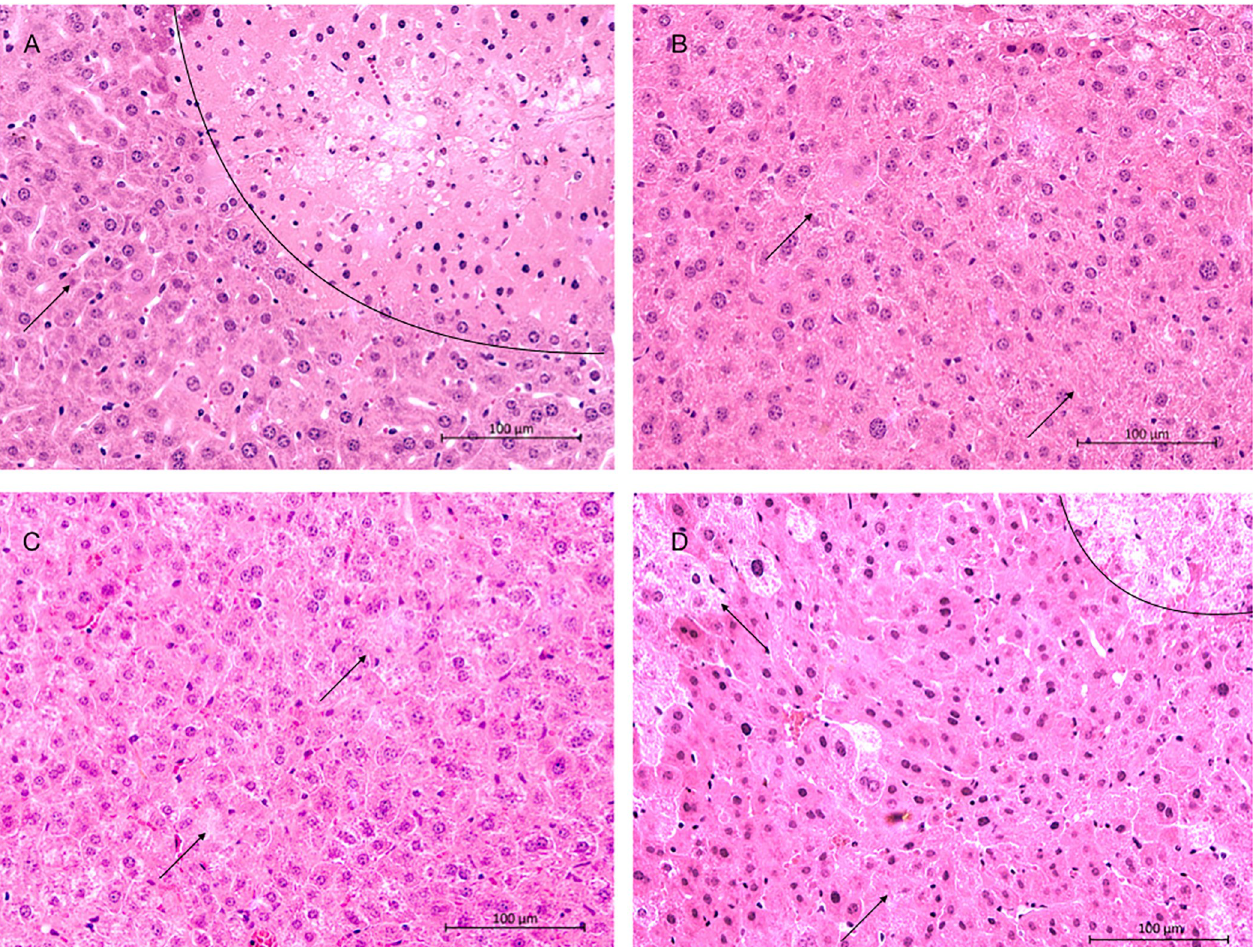
Fig 7. Representative histologic sections of liver parenchyma, stained with hematoxylin and eosin. (A) Representative section of tissue from a liver in the vehicle group. The curved black line indicates transition between normal tissue (left side of line) and necrotic liver (right of the line). (B) Representative section of tissue from a liver in the F573 group. (C) Representative tissue from the anakinra and etanercept group. (D) Liver tissue from the BMX-001 group. The curved black line indicates transition between normal tissue (left side of line) and necrotic liver (right of the line). All photographs are shown at 20X magnification. Arrows indicate areas of liver damage relevant to the scoring system, including necrosis and hemorrhage.